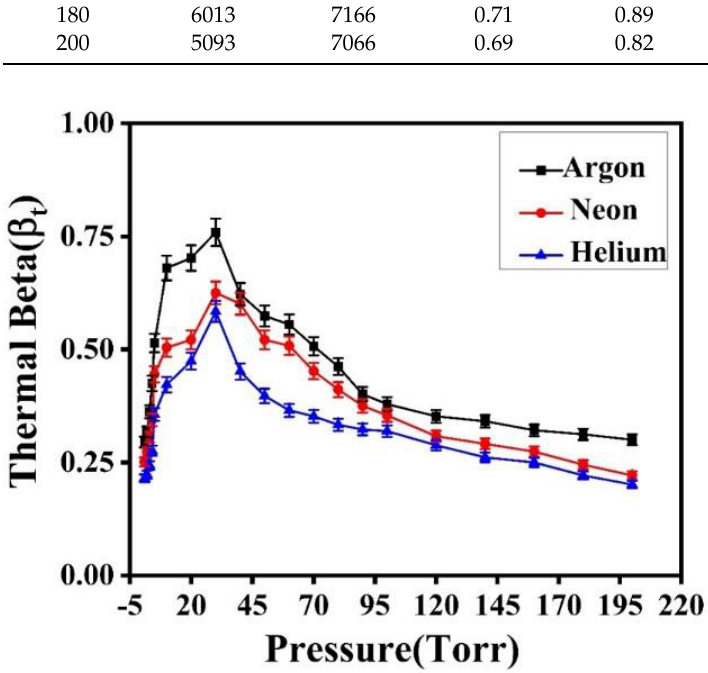
Figure 8. The variation in thermal beta of laser-induced Cu alloy plasma at various pressures under Ar, Ne, and He environments at ns laser irradiance of 3.8 GW/cm 2 .